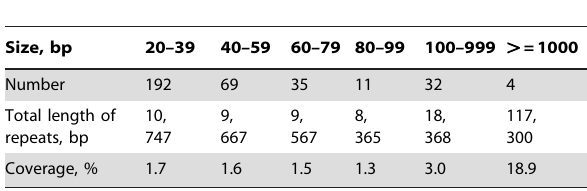
Table 3. Frequency distribution of repeat lengths in the mt genome of Gossypium